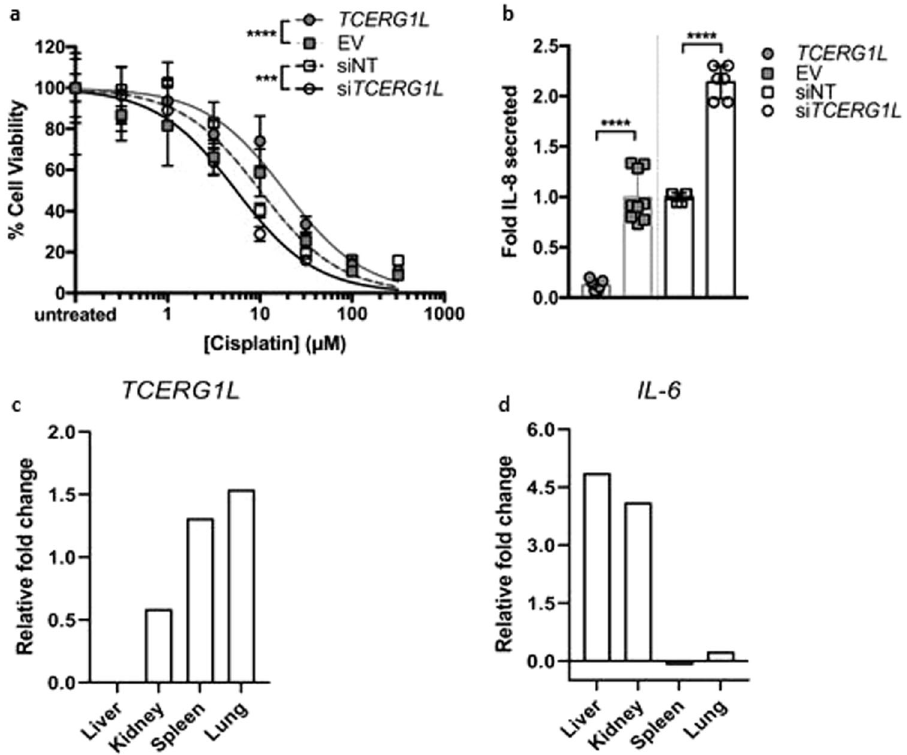
Fig. 2 TCERG1L expression in fl uences in vitro and in vivo responses to cisplatin. a TCERG1L overexpression ( TCERG1L ) and silencing (si TCERG1L ) in HeLa cells signi fi cantly reduces and enhances cisplatin cytotoxicity, respectively, compared to empty vector (EV) or non- targeting (siNT) controls. Cisplatin CC 50 was 5.5 μ M (si TCERG1L ) and 18.6 μ M ( TCERG1L ). Control conditions (EV, siNT) cisplatin CC 50 was 10 μ M. *** P < 0.001; **** P < 0.0001 using extra sum of squares F test; n = 21 from three independent experiments (overexpression) and n = 9 from two independent experiments (silencing). Data are shown as the mean and standard deviation. b Pro-in fl ammatory IL - 8 secretion at 100 μ M cisplatin was signi fi cantly reduced, or enhanced, by TCERG1L overexpression and silencing in HeLa cells compared to their respective controls. **** P < 0.0001 using two-tailed Student t -test; n = 6 or 9 from two independent experiments. Standard deviation is shown. Overexpression and silencing experiments were performed separately but shown on the same axes for comparison in a and b . RNA expression changes of TCERG1L ( c ) and IL-6 ( d ) across several mouse tissues following cisplatin exposure. Relative fold changes were calculated per organ against saline-injected controls. The data set is publicly available in the NCBI Gene Expression Omnibus (GEO) under accession number